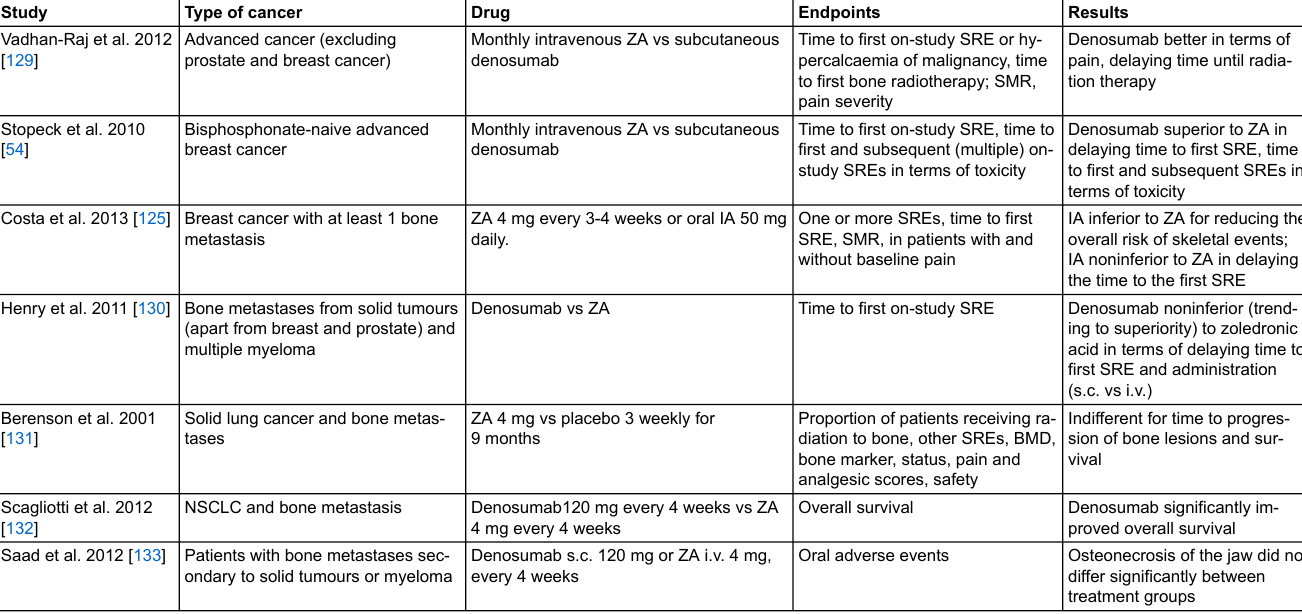
Table 2: Selected phase III trials with bone targeting agents in metastatic breast and other cancer types. Study